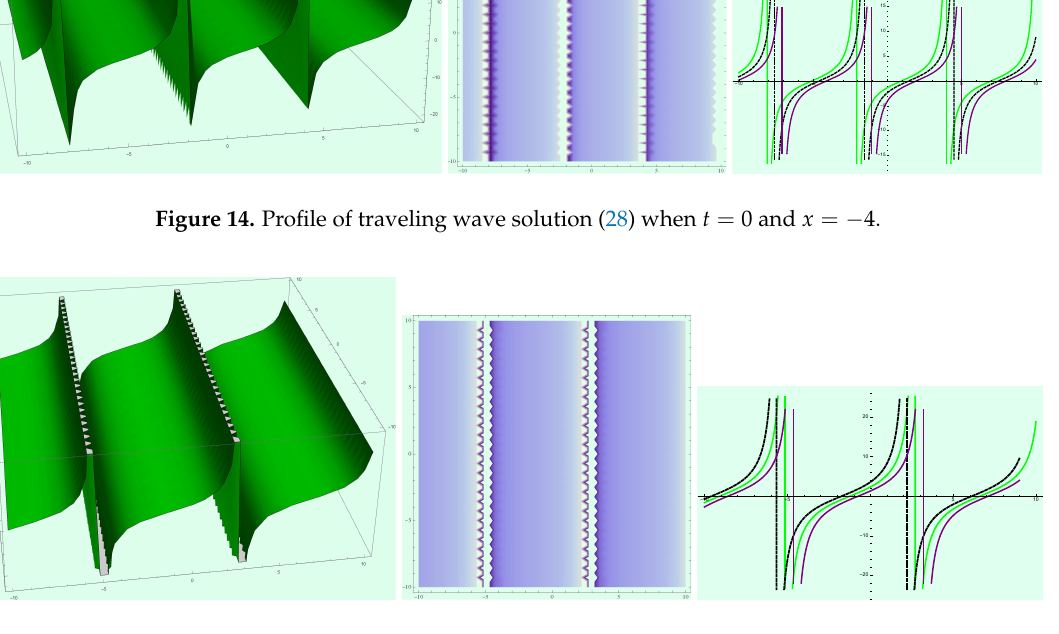
Figure 15. Profile of traveling wave solution (28) when t = − 6 and x =